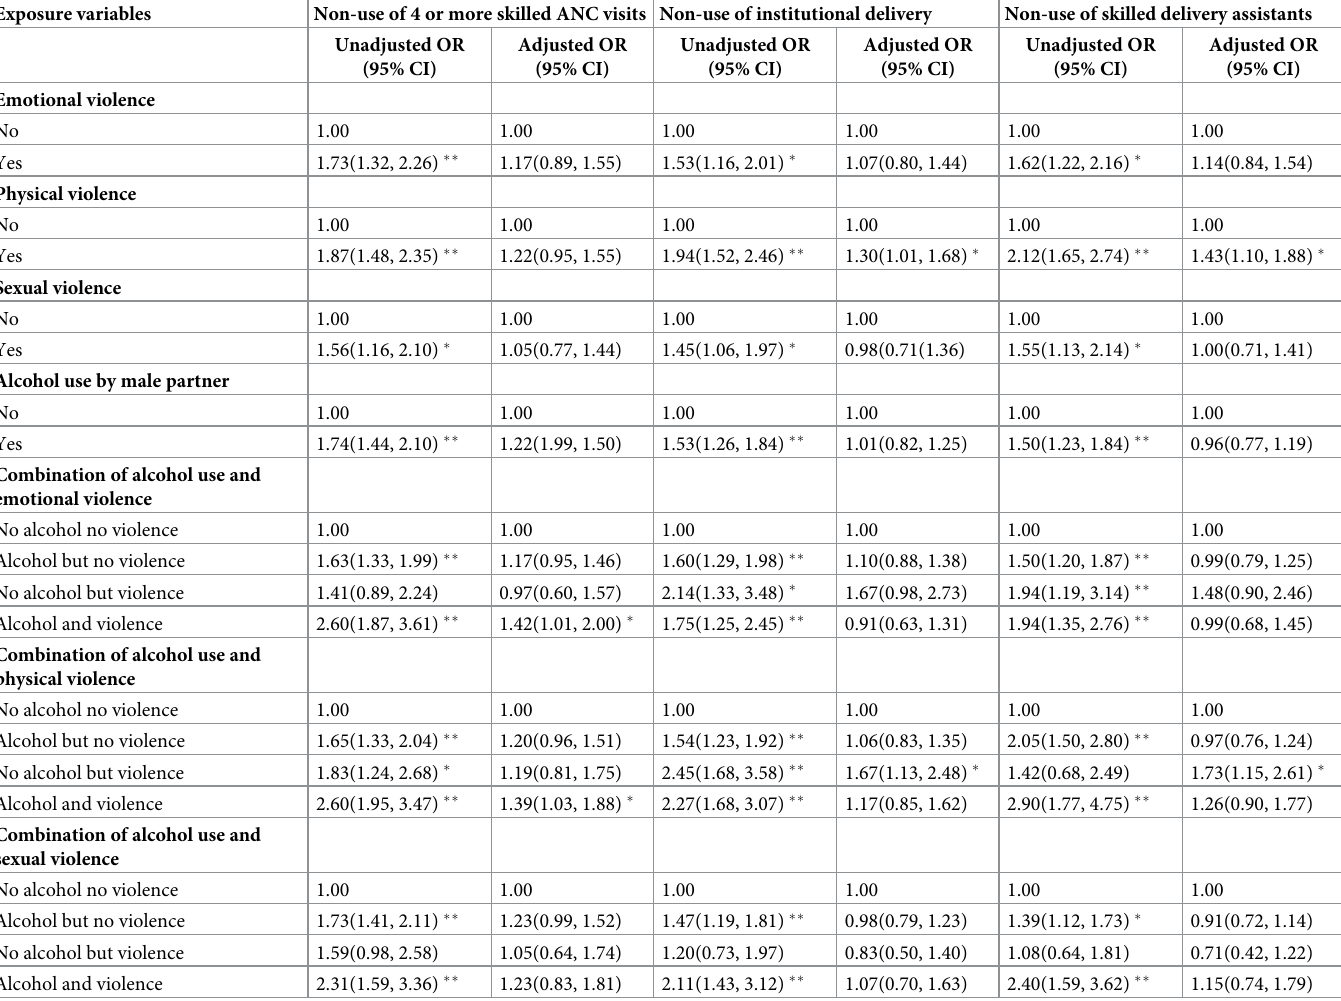
Table 2. Impact of alcohol use and different forms IPV on receipt of perinatal care in Nepal (20011–2016). Exposure